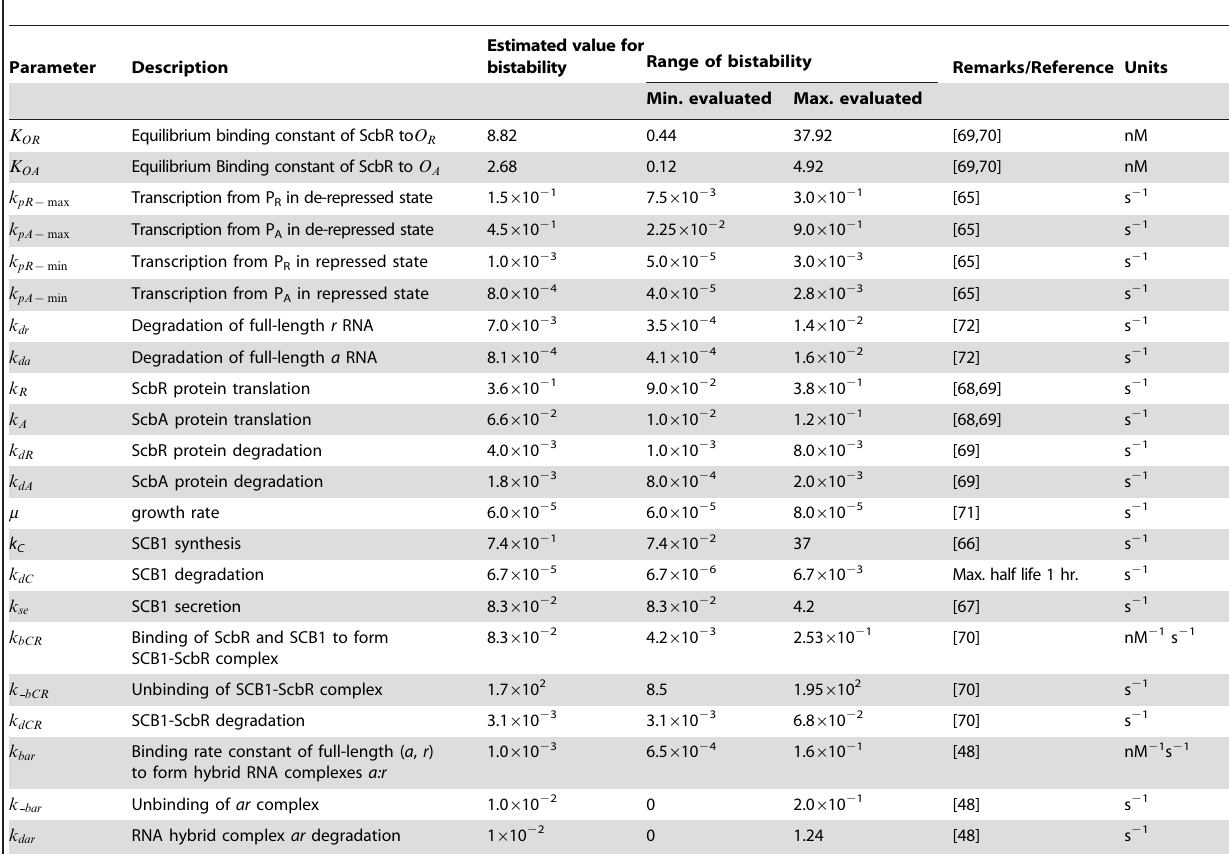
Table 3. Parameter values and their range for which bistability is observed.